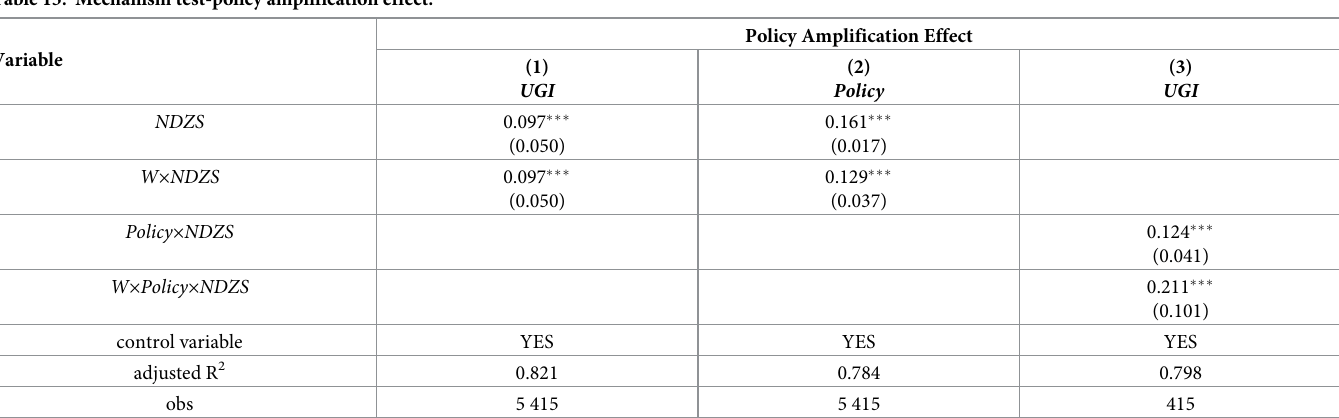
Table 13. Mechanism test-policy amplification